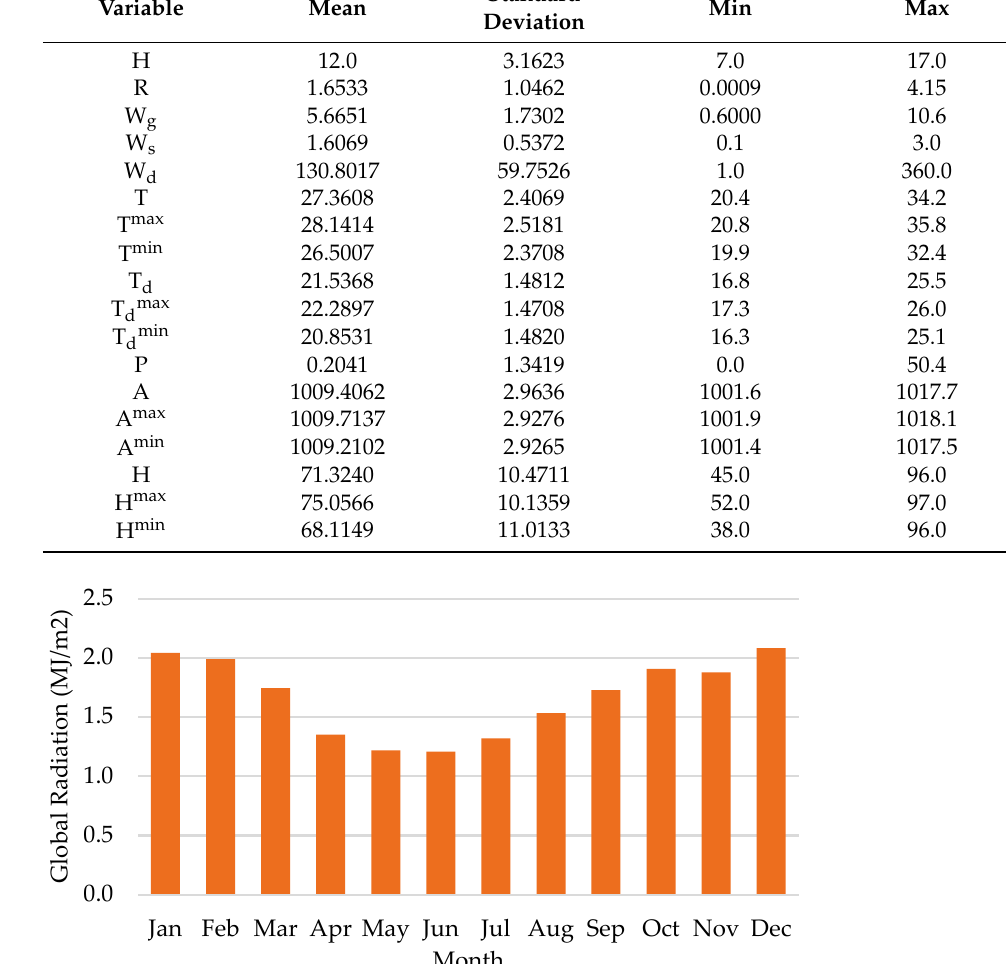
Table 2. Statistical features of the available database.